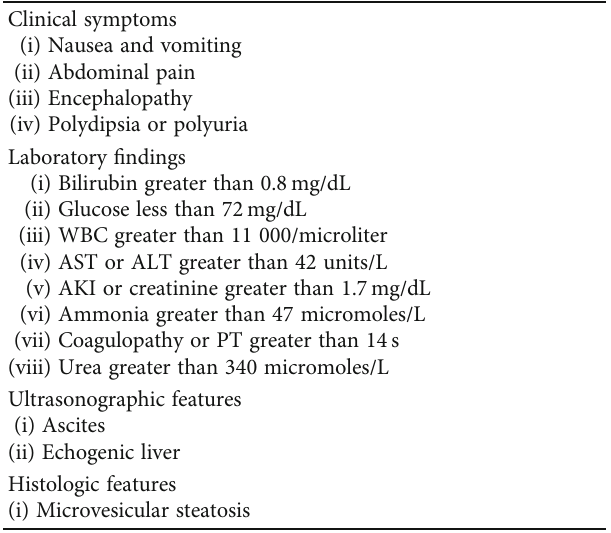
Table 1: Swansea criteria for